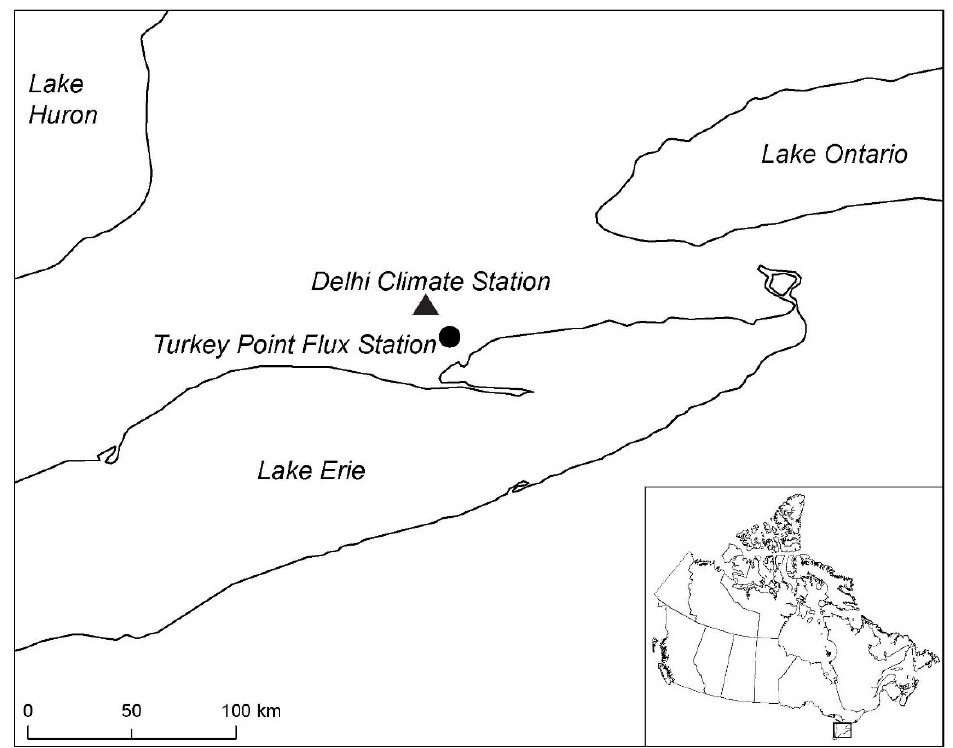
Figure 1. Location of the Turkey Point Flux station on the north shore of Lake Erie in Southern Ontario, Canada. The location of closest (25 km away) long-term climate station at Delhi maintained by Environment Canada is also